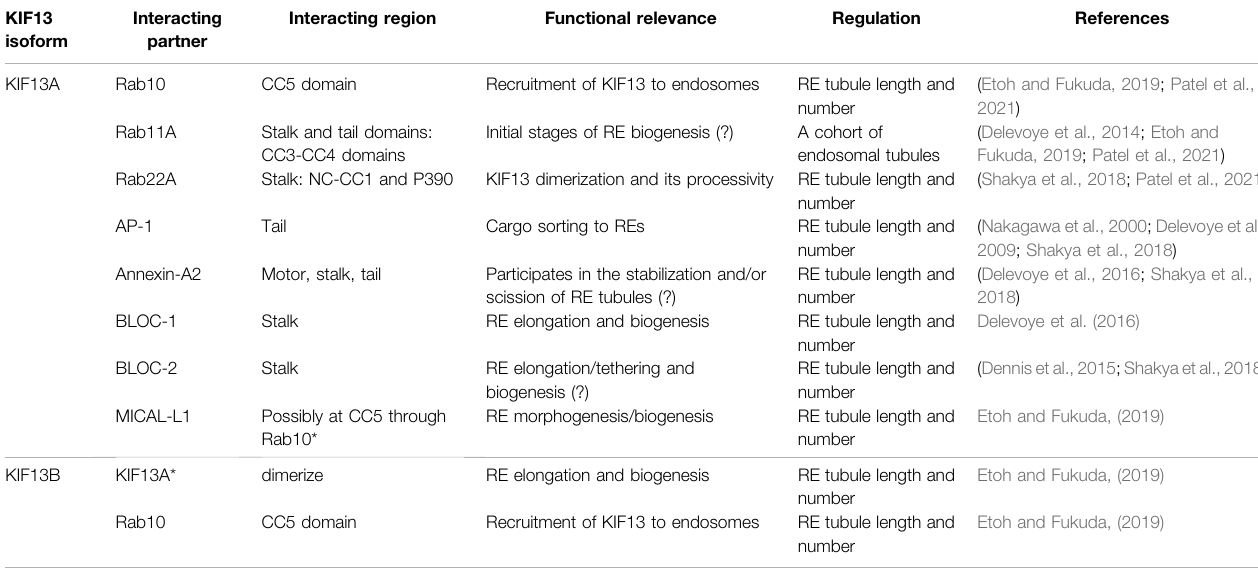
TABLE 2 | List of interacting partners/regulators of